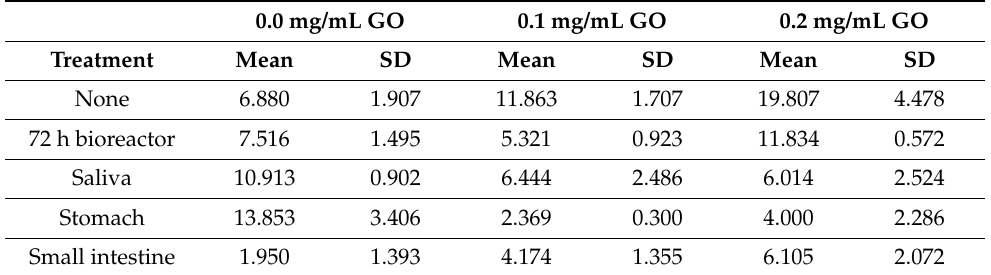
Figure 6. Evaluation of hydrogels’ mechanical response. ( A ) Firmness for chemically cross-linked hydrogels before and after the milli-bioreactor operation. ( B ) Hydrogel firmness after exposure to gastrointestinal tract simulated media at different pH values. *, p < 0.05. Table 1. Arithmetic mean and standard deviation of the hydrogels’ firmness for the different treatments studied.